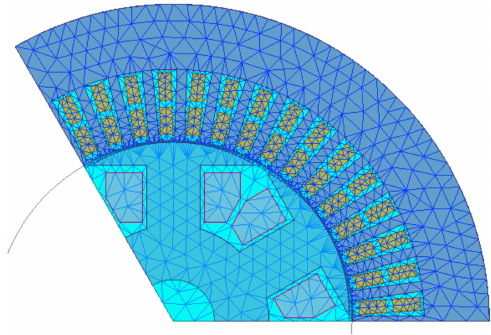
Figure 2. Generator 2D transient field dissection diagram.